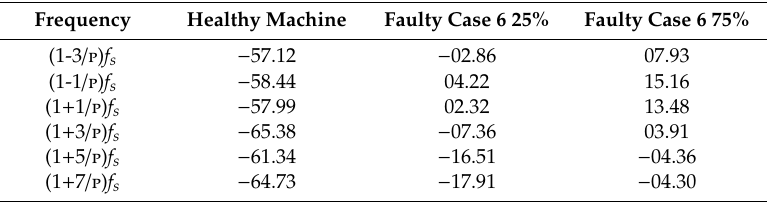
Table 6. Current harmonic components comparison due to case 6 (in dB).